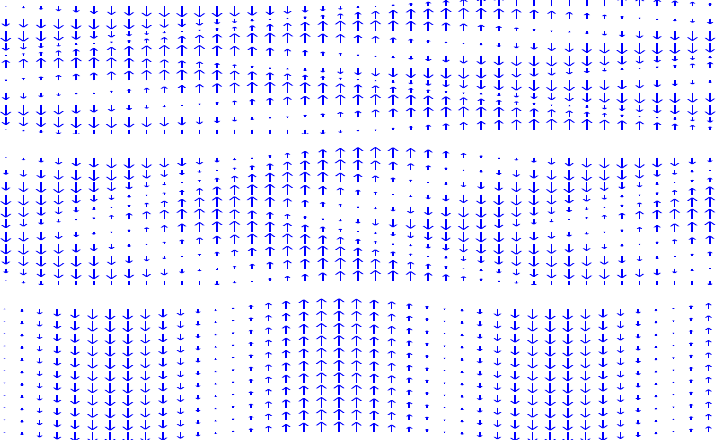
Figure 4. Displacement of the electric field according to (4.1) for a given ω , when γ = 0 . 6, γ = 0 . 9 and γ = 1, respectively. The non-stationary boundary conditions are the same on the lower and upper plates, but the information reaches with a delay (depending on γ ) the center of the